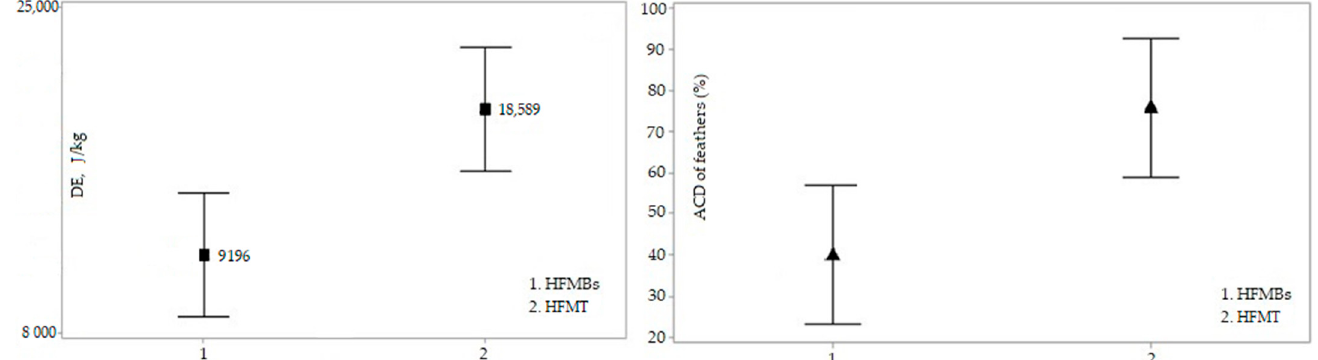
Figure 2. Digestible energy values for HFMBS and HFMT in adult dogs (HFMBS: 9196 J/kg; HFMT: 18,589 J/kg; p < 0.05). Different means by the Tukey test 5%. Apparent total tract digestibility values for HFMBs and HFMT energy (HFMBs: 40.0; HFMT: 76.0, p < 0.05). Different means by the Tukey test 5%.